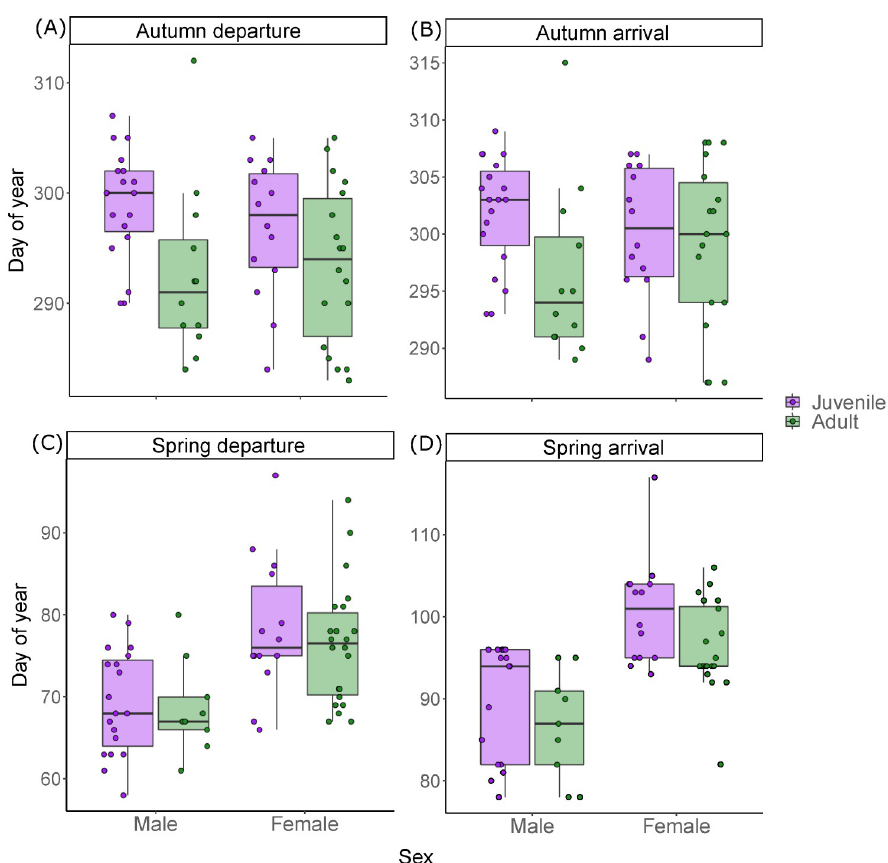
Fig 1. (A-B) Autumn and (C-D) spring migration departure and arrival timing for adult and juvenile Cyprus wheatears. Timing events are estimated from light-level geolocator data. Geolocator tags were deployed in 2017, 2018 and